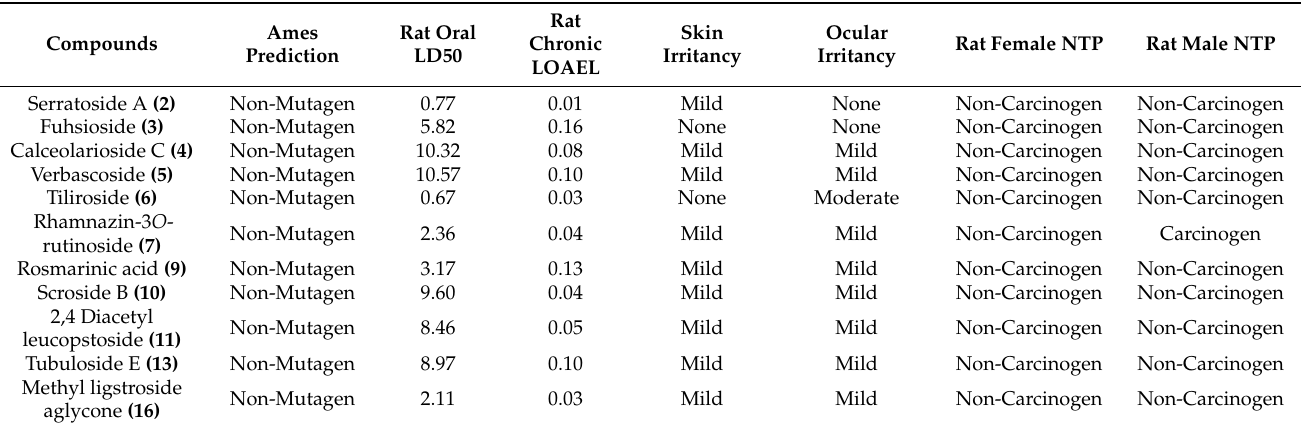
Table 5. TOPKAT prediction of the major compounds identified in the total methanol extract of C. speciosum